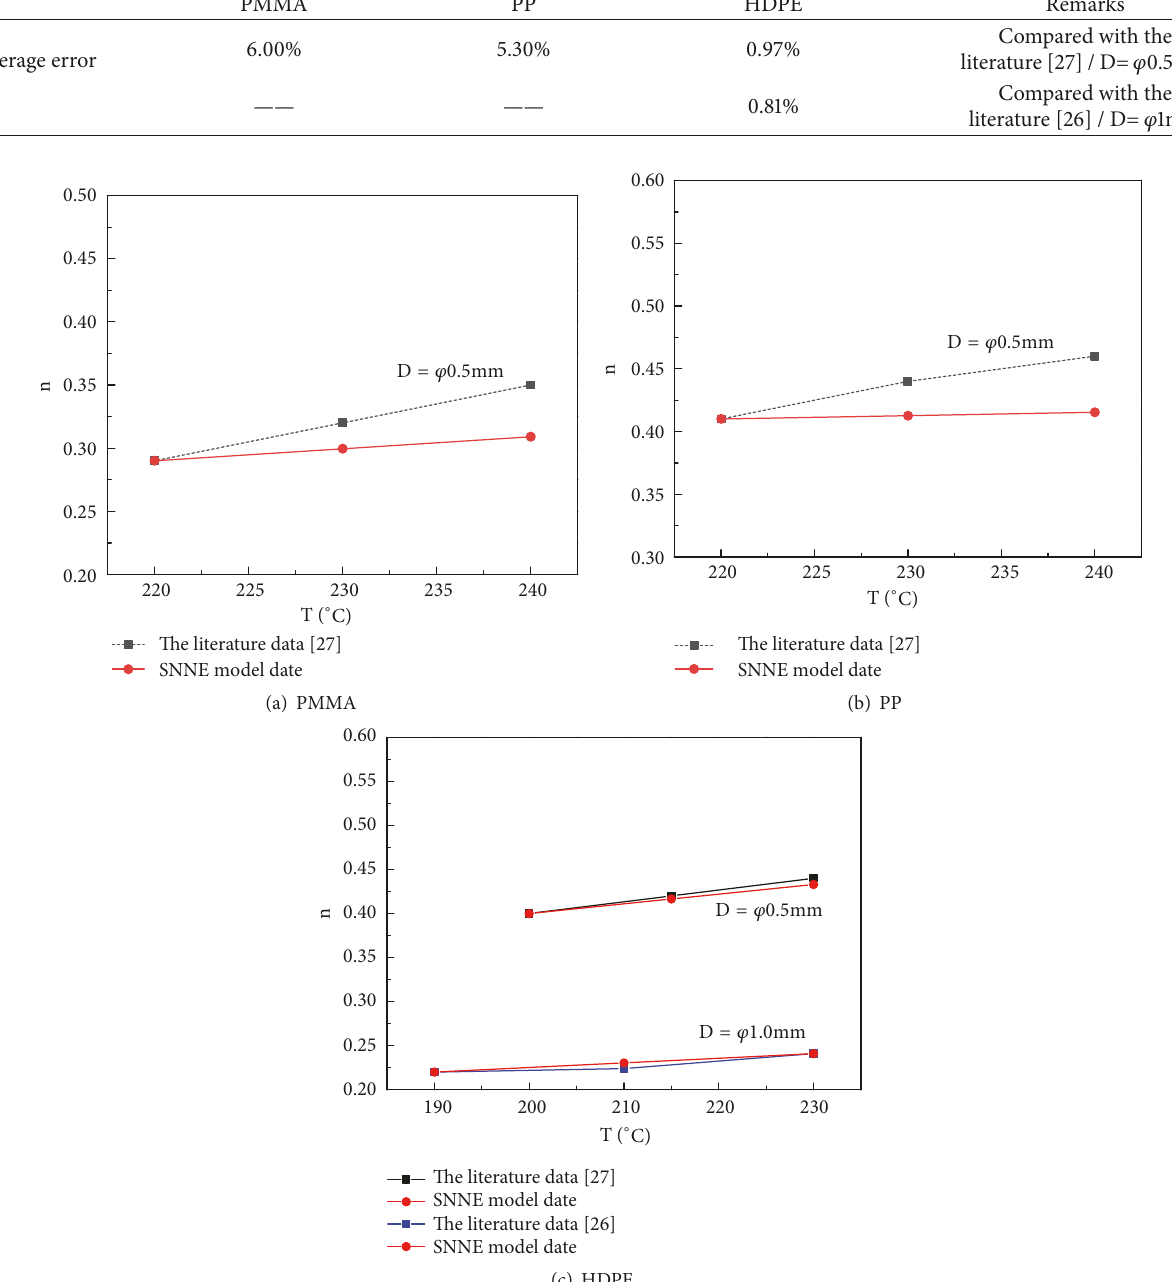
Figure 7: Comparison of non-Newtonian index between SNNE model and the literature data. (a) PMMA; (b) PP; (c) HDPE.